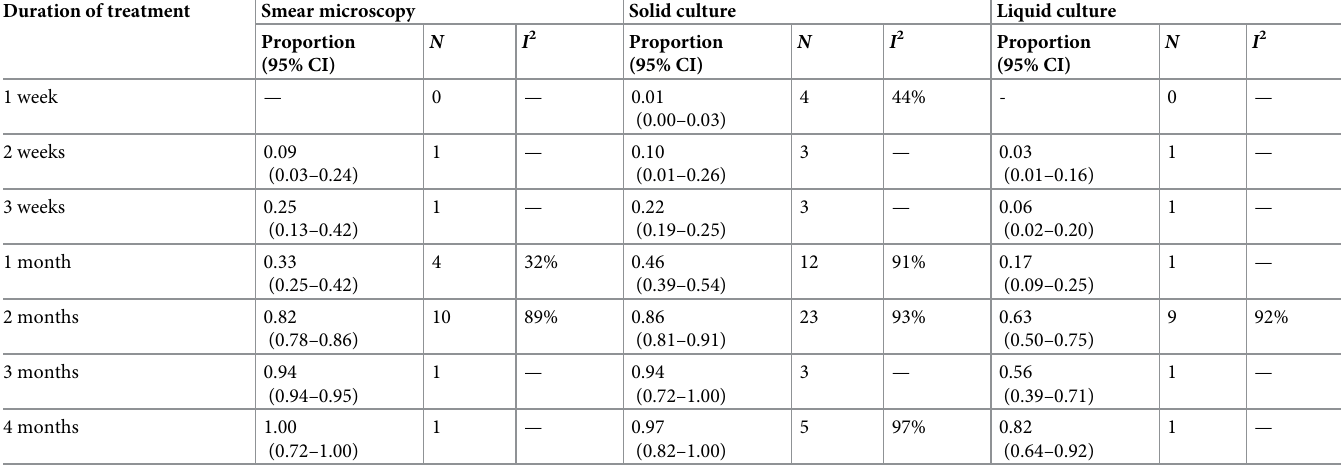
CI, confidence interval; N , number of